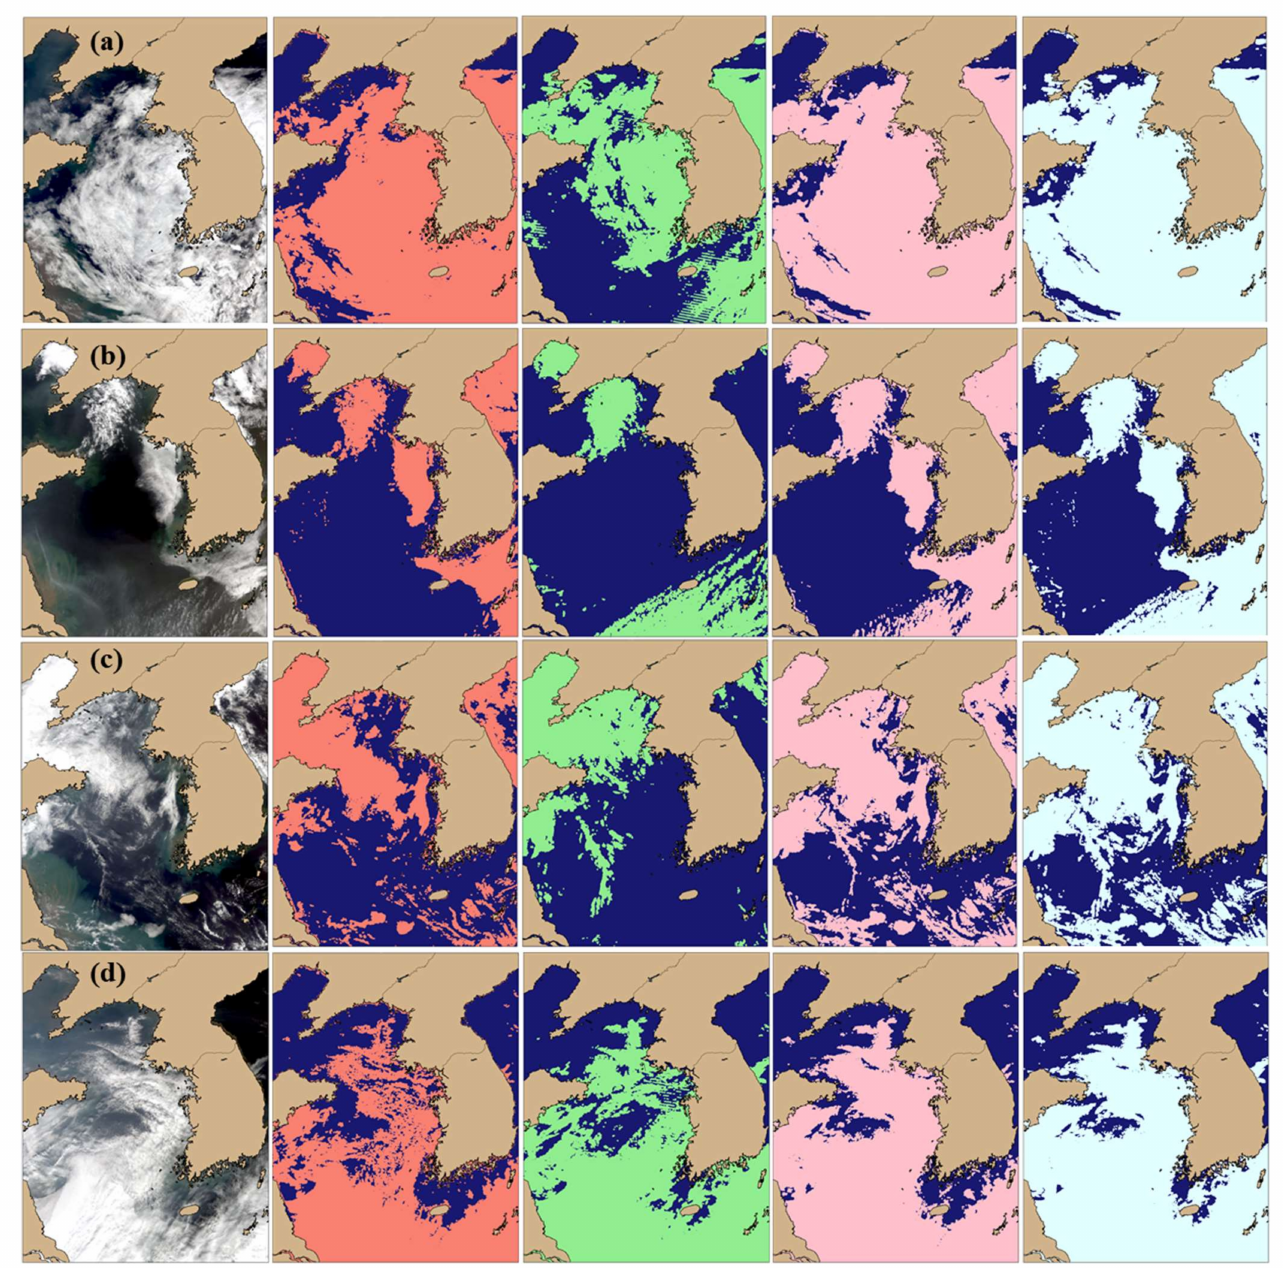
Figure 7. Case studies: (first column) MODIS RGB images, (second column) cloud mask using only NDWI–green band relationship, (third column) cloud mask using only R 1.38 µ m method, (fourth column) cloud mask using only R 1.61 µ m method, and (fifth column) cloud mask using the proposed cloud detection method (combination of ( b – d )) on ( a ) 29 April 2014, 02:20 UTC (spring); ( b ) 12 June 2015 02:15 UTC (summer); ( c ) 4 October 2019, 02:15 UTC (autumn); and ( d ) 6 January 2016, 02:15 UTC